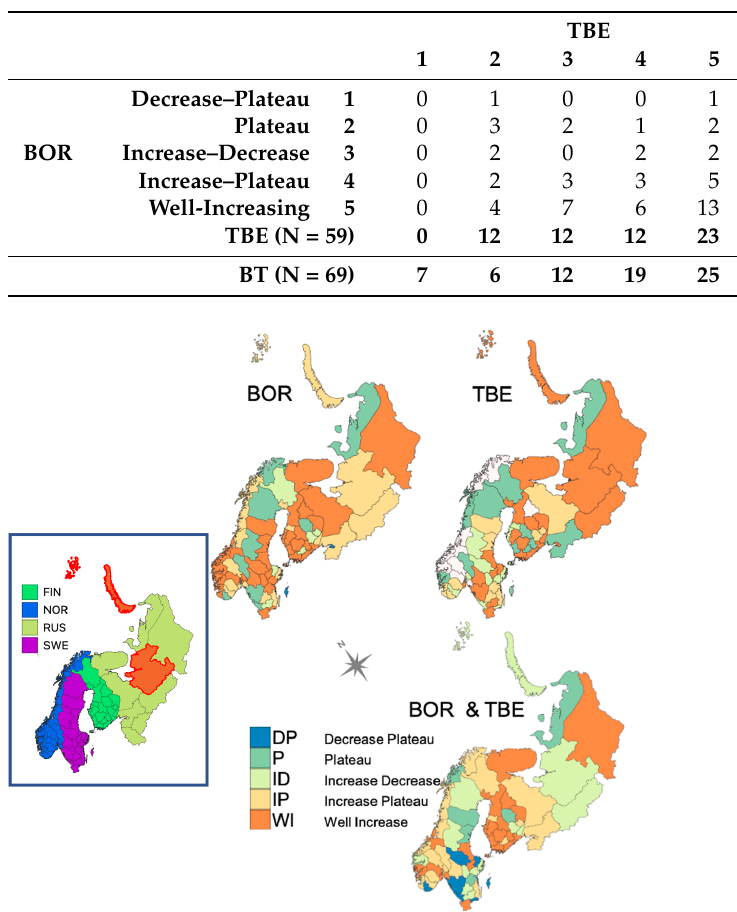
Table 1. Distribution of incidence pattern groups for BOR (rows), TBE (columns), and total incidence (BT) (10 districts in Norway had no TBE reports).